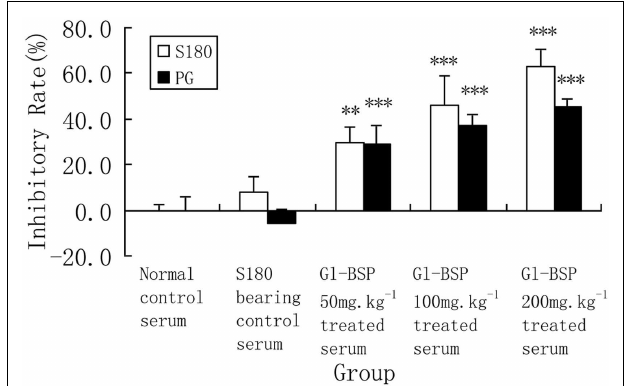
FIGURE 1 | Effect of Gl -BSP-treated serum on proliferation of S180 and PG cells in vitro ( n = 9, ¯ x ± s). Mice were implanted with Sarcoma 180 and Gl -BPS (50, 100, or 200mgkg − 1 ) or physiological saline were administrated intragastrically for 14days. At the end of experiment, blood samples were collected from the orbital vein and the serum was sterilized by filtration. A cell suspension (2 × 10 7 cell per liter) was made with 5% FCS RPMI-1640, planted onto 96-well culture plates (0.1ml per well), and incubated at 37ºC, 5% CO 2 for 24h.The media was replaced with 0.1ml of